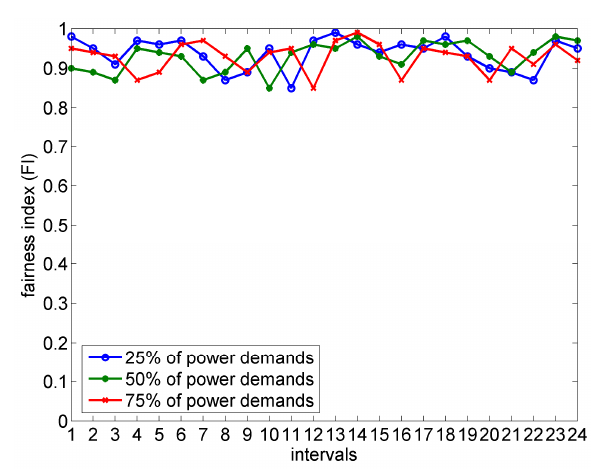
Figure 9. The FI in three test scenarios.